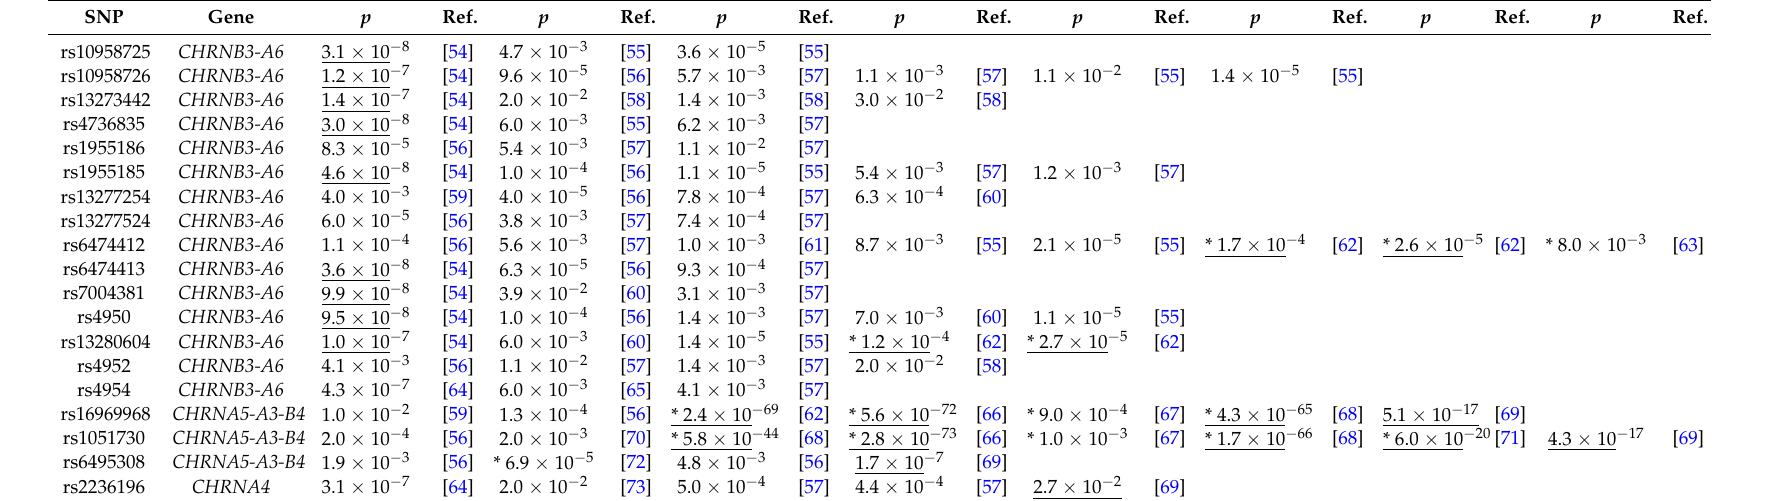
Table 1. Replicated associations between CHRN genes and nicotine